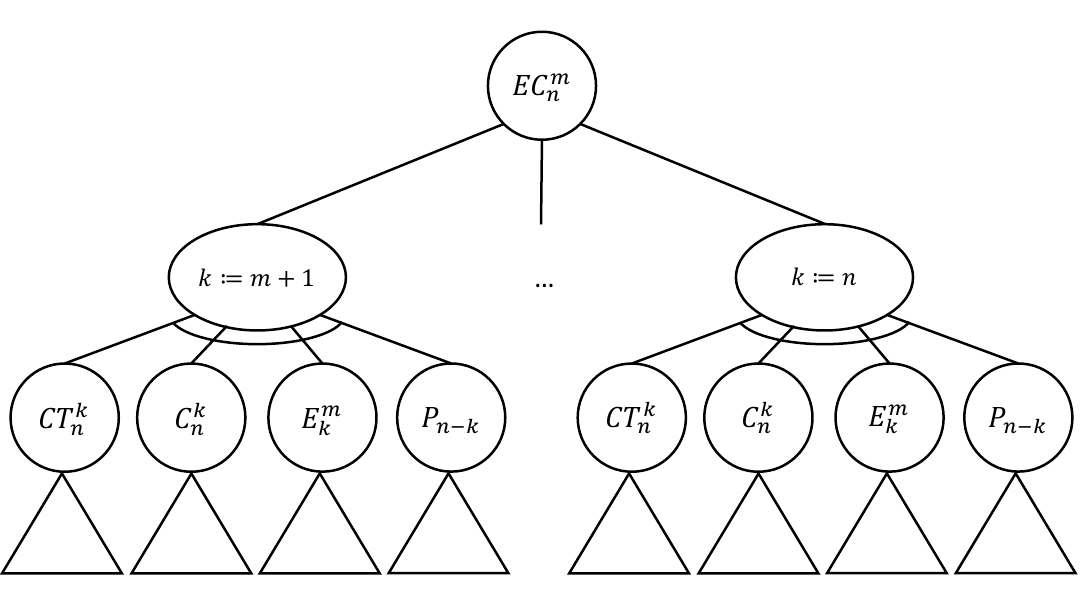
Figure 4. An AND/OR tree for EC m n .